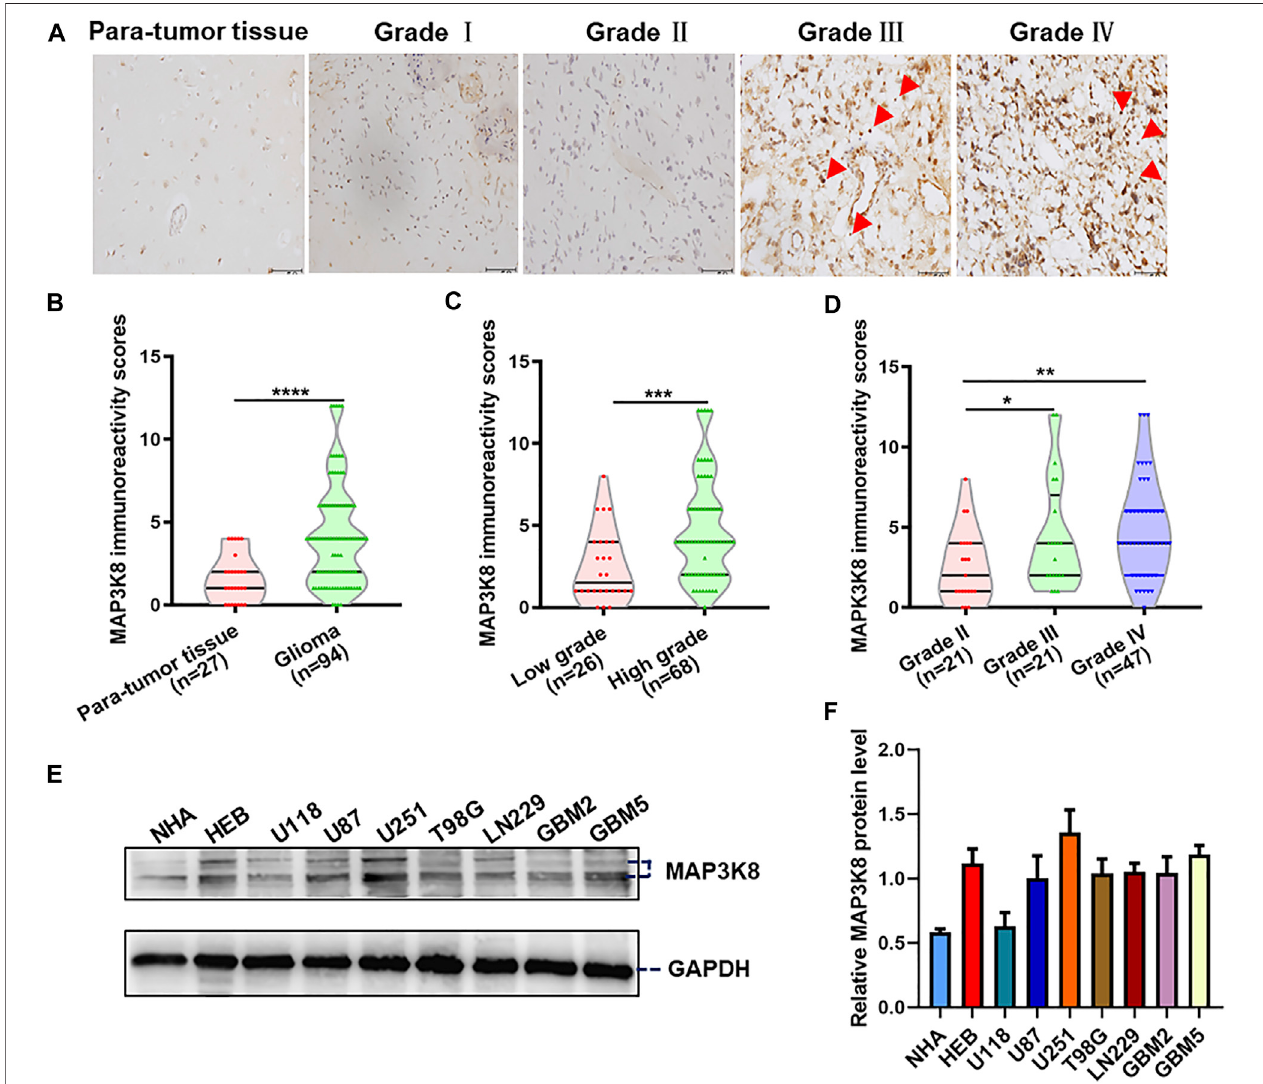
FIGURE 2 | MAP3K8 was aberrantly overexpressed in glioma tissues and cell lines. (A) Representative immunohistochemistry (IHC) images of MAP3K8 in human para-tumor and glioma tissues. Scale bar , 50 μ m. (B) MAP3K8 immunoreactivity score analyzed in human para-tumor and glioma tissues. (C) MAP3K8 immunoreactivity scores analyzed in low-grade and high-grade glioma tissues. (D) MAP3K8 immunoreactivity scores analyzed in grade II, grade III, and grade IV glioma tissues. (E , F) Expression of MAP3K8 in indicated cell lines evaluated by Western blot; statistical analysis was performed. Error bars , SD.